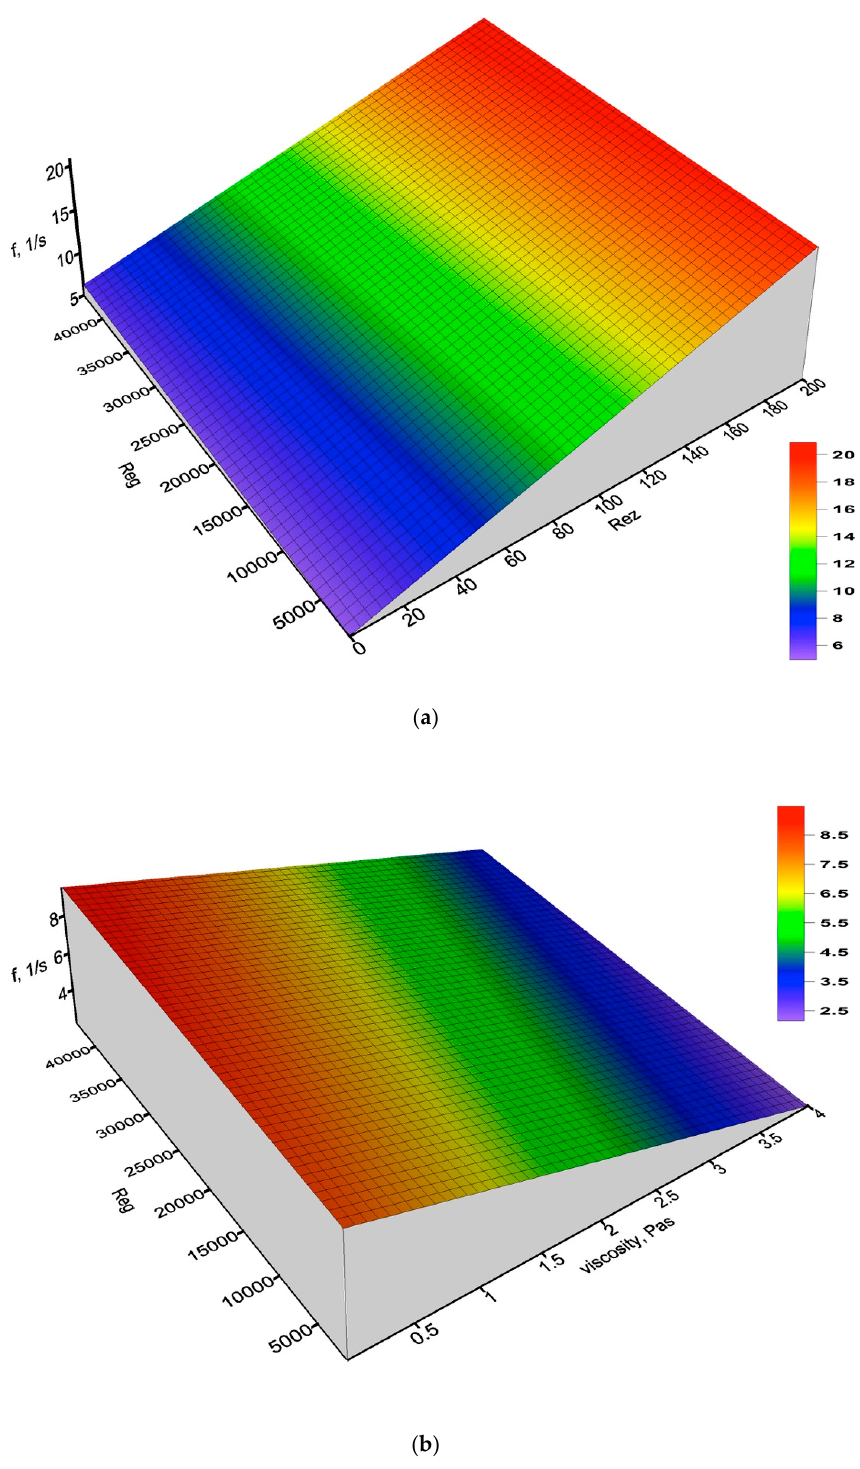
Figure 14. Results of calculations of wave frequency accompanying two-phase gas-very viscous liquid flow for relation (14). (a) depending on Re z value; (b) depending on the viscosity value.